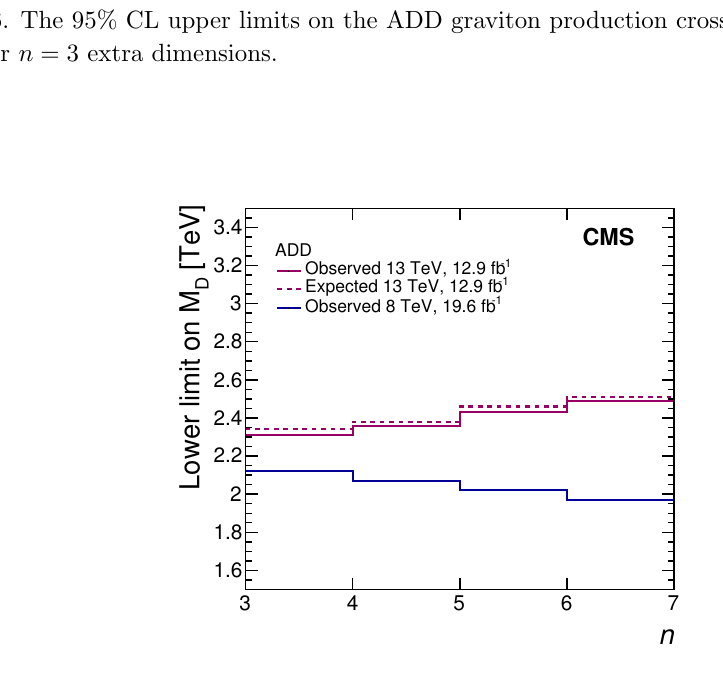
Figure 7 . Lower limit on M D as a function of n , the number of ADD extra